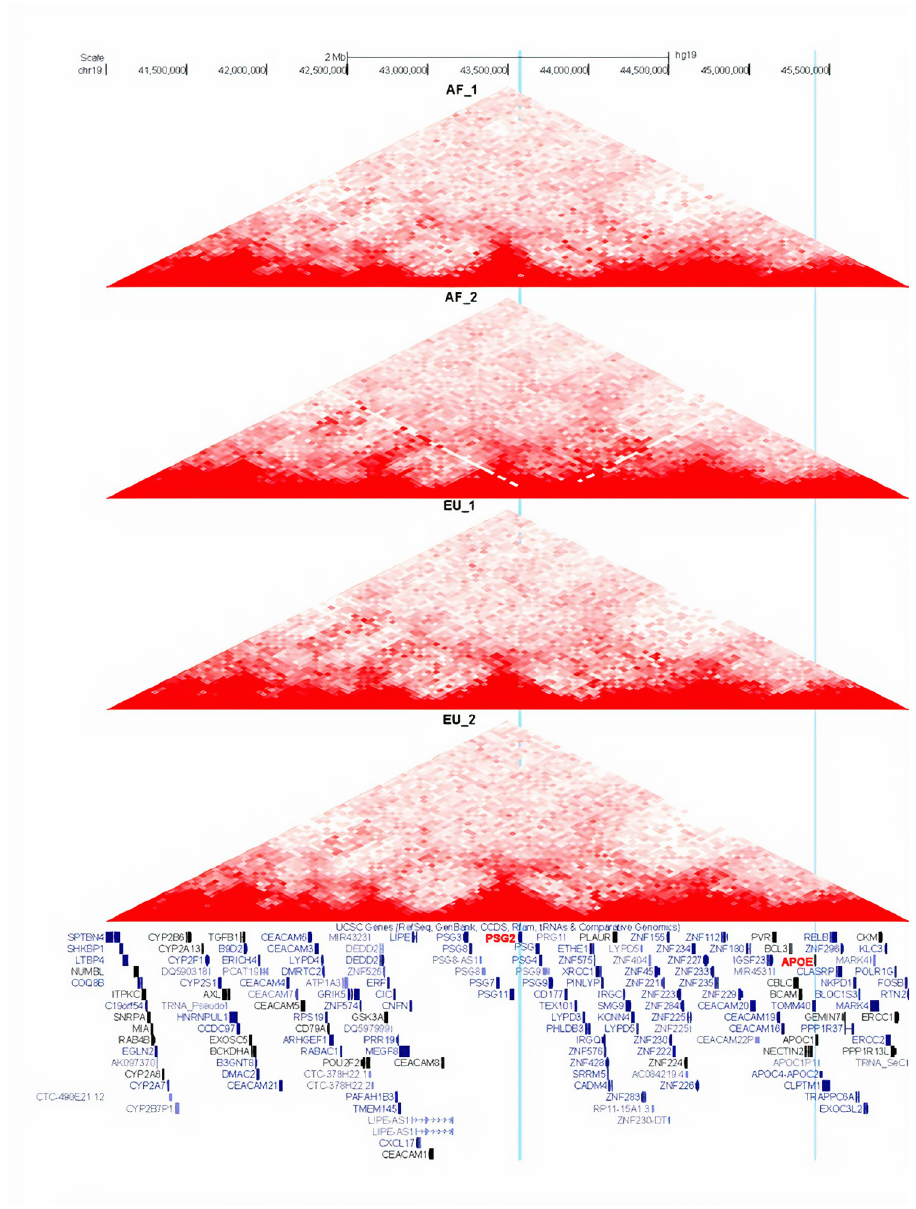
Fig 5. Chromatin Loops in chromosome 19 region centering on PSG2 and ApoE genes are displayed in four tracks, each representing one astrocyte line. Induced pluripotent stem cells (iPSCs) with African (20–1611720 and LWHiC, top two tracks) or non-Hispanic White local ancestry (20–1616981 and 201–806023, bottom two tracks) were differentiated into astrocytes. Chromatin Hi-C library was constructed with 4-cutter enzyme. Blue vertical bar highlights rs10423769; yellow vertical bar highlights ApoE